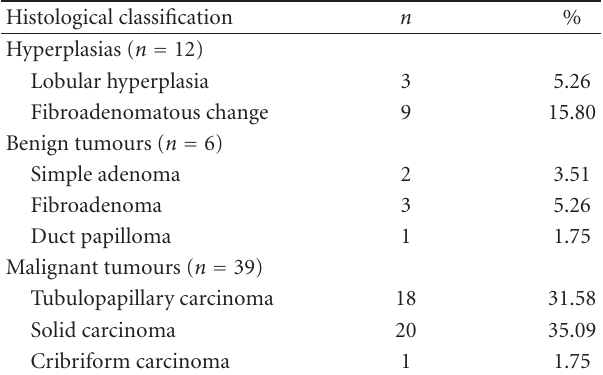
Table 1: Histological classification of mammary lesions and their absolute and relative frequencies.